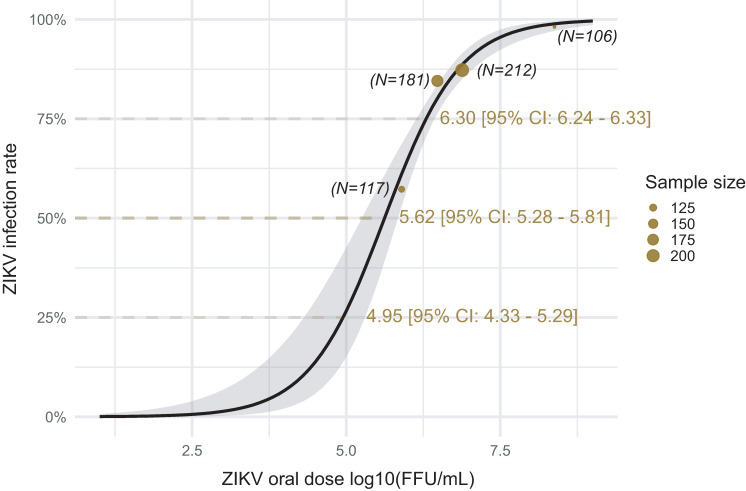
Dose response curve representing Ae. albopictus mosquito infection rate as a function of ZIKV oral dose.Golden dots correspond to infection rates observed on Ae. albopictus mosquitoes at each infectious blood-meal titer. Dots size is proportional to the number of samples. The black line corresponds to fit values obtained by fitting a logistic model to the data. The grey ribbon indicates the 95% confidence intervals. The dose to infect 50% of the ZIKV exposed mosquitoes (ID-50), the 25th and 75th percentile are represented with their 95% confidence intervals.